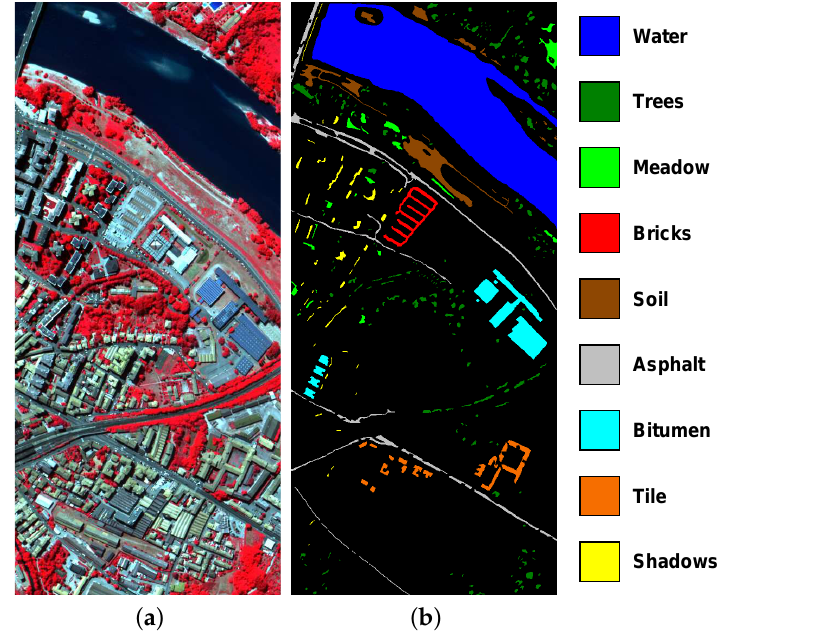
Figure 6. ROSIS Center of Pavia dataset. ( a ) RGB composite image. ( b ) Ground reference map.